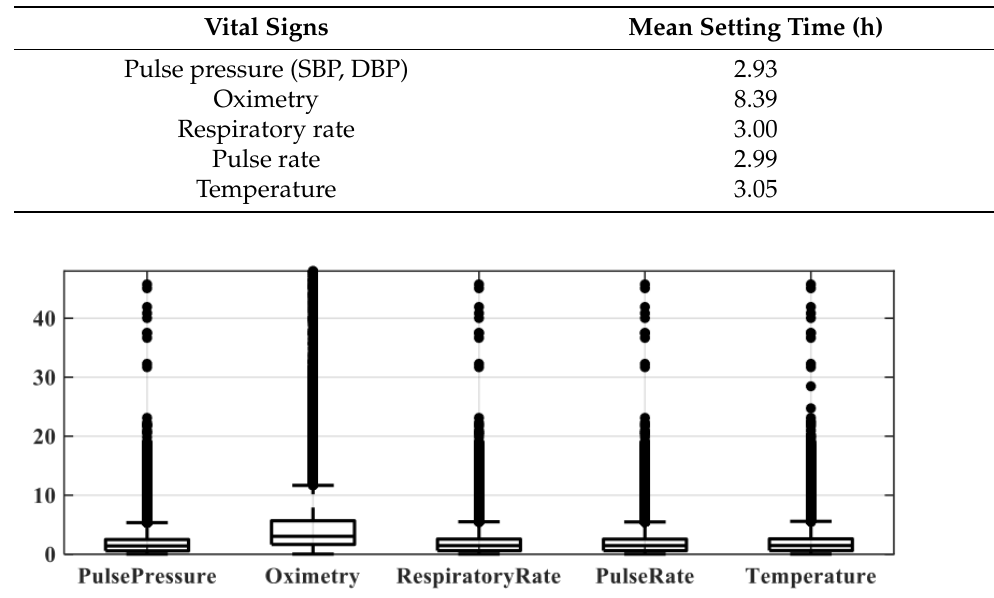
Figure 4. Visualization plot for setting time between different vital